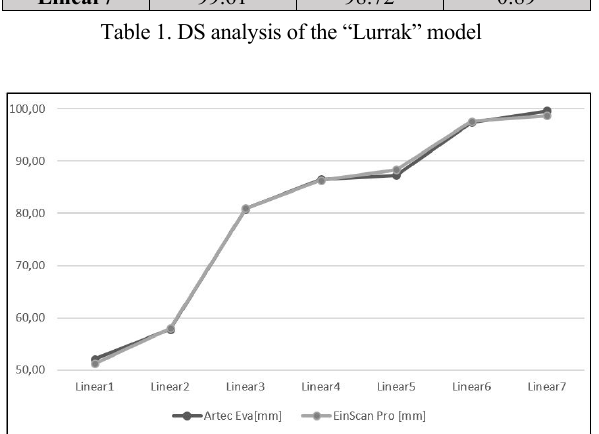
Figure 3. Graph of the DS analysis of the “Lurrak”